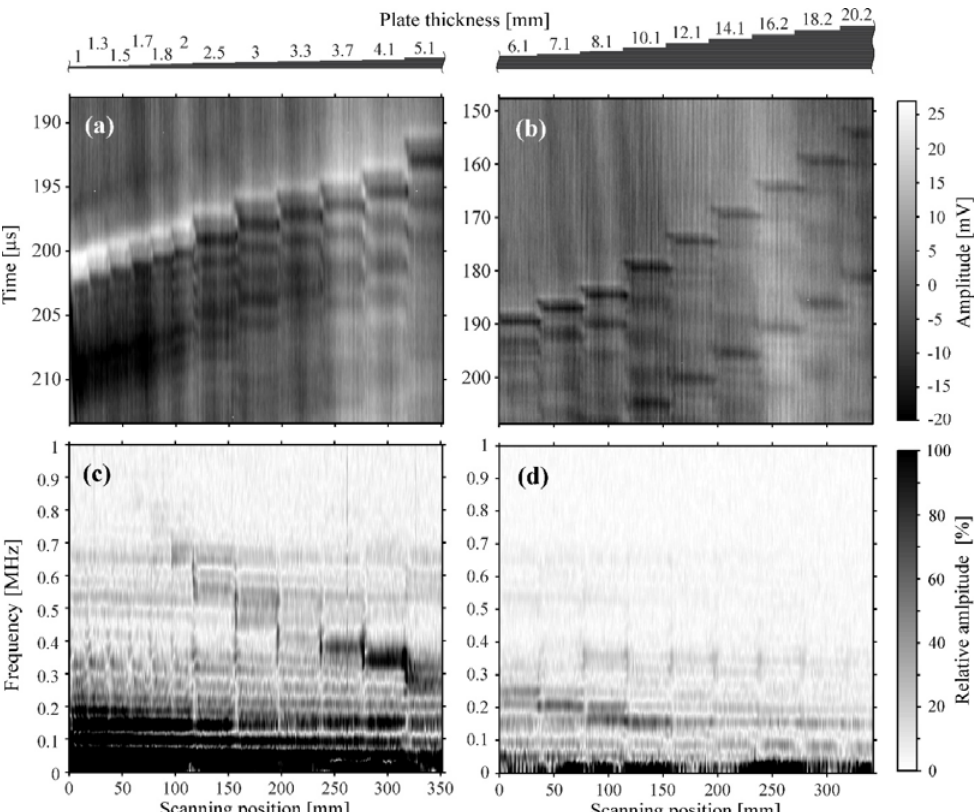
Figure 3. B − scans for thinner ( a ) and thicker ( b ) plate thickness ranges. The signals in frequency domain are shown in S − scans (B − scans in frequency domain) for the same positions of both linear scans in ( c , d ). The TR frequency is inversely proportional to the plate thickness, while the ToF is linearly proportional to the plate thickness.